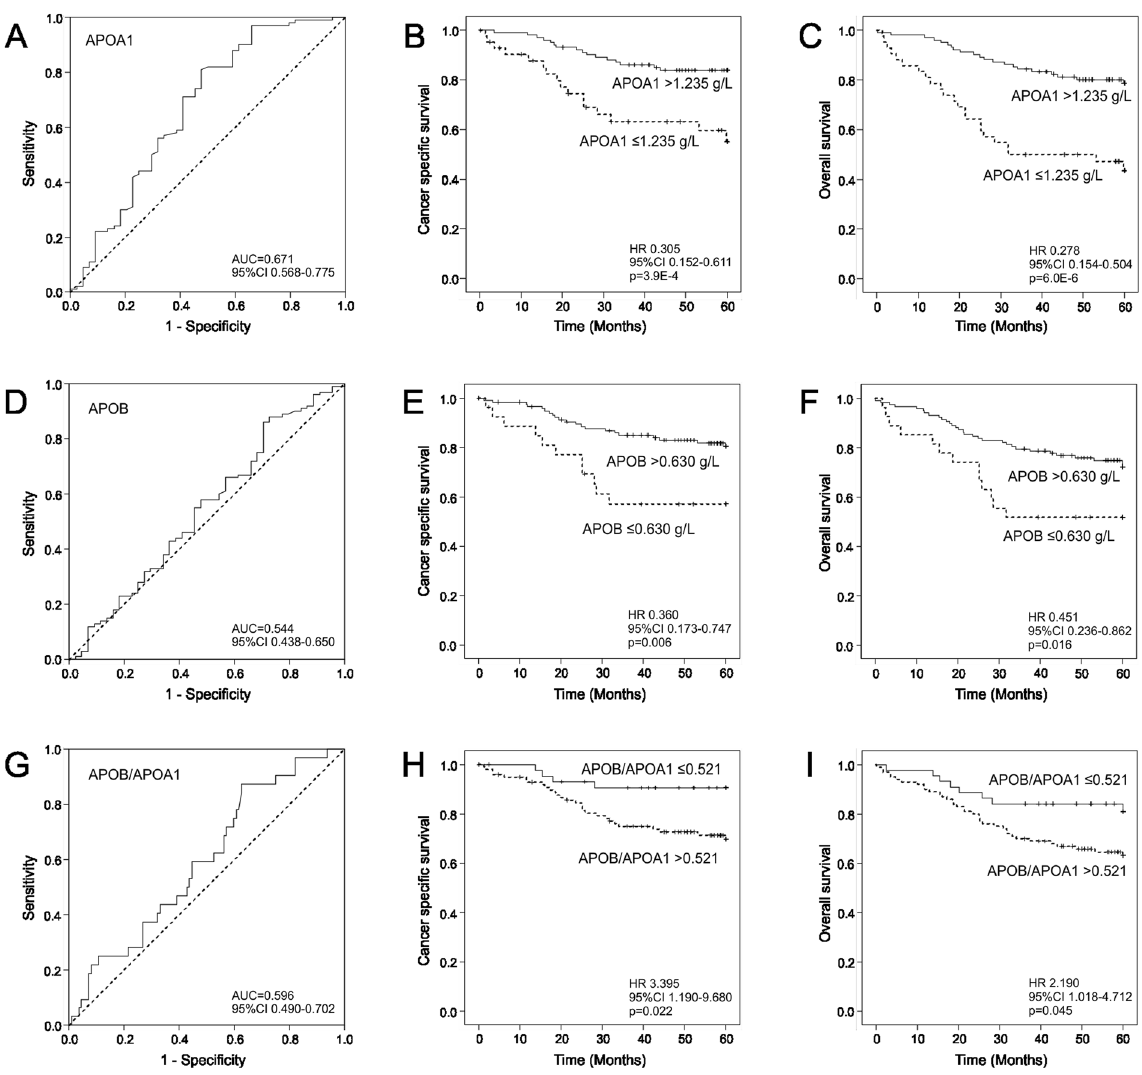
Figure 1. Survival analyses. ( A ) Receiver operating characteristics (ROC) curve for serum APOA1 in predicting overall survival (OS). Kaplan-Meier curves show that higher serum APOA1 level associates with better cancer-specific survival (CSS) ( B ) and overall survival ( C ). ROC curve for serum APOB in predicting OS ( D ). Serum APOB level and CSS ( E ). Serum APOB level and OS ( F ). ROC curve for serum APOB/APOA1 ratio in predicting OS ( G ). Serum APOB/APOA1 ratio and CSS ( H ). Serum APOB/APOA1 level and OS ( I